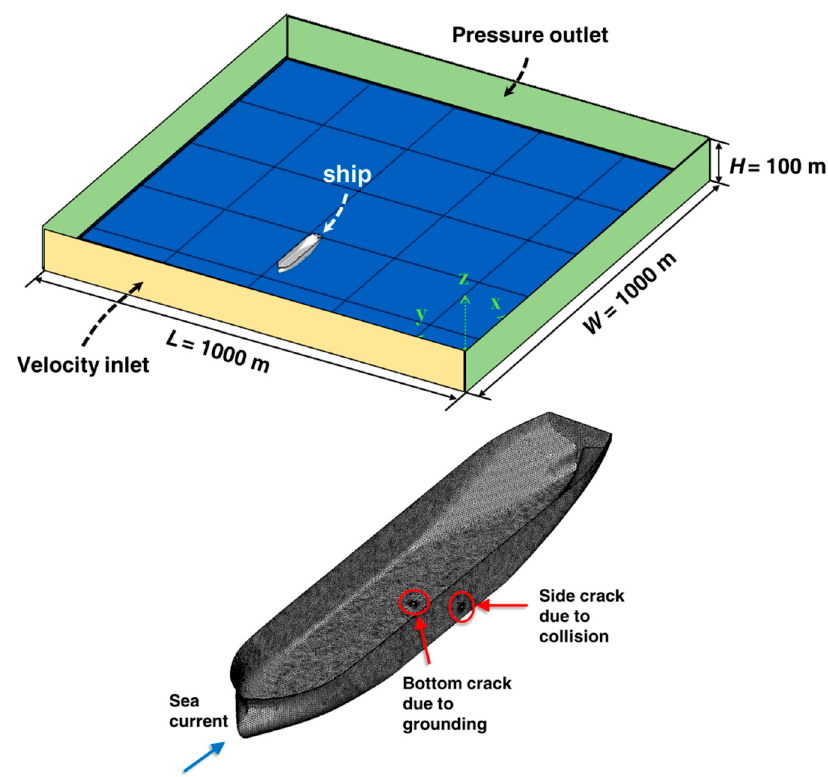
Figure 1. Schematic of the computational domain and accident ship.